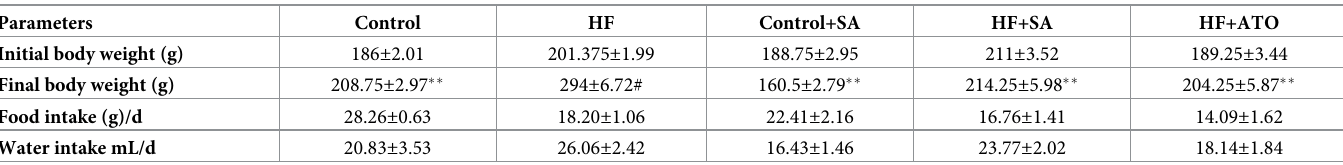
Data are presented as mean ± SEM, n = 8. For statistical analysis, one-way ANOVA with Tukey’s multiple comparison test was performed. �� Versus # represents p �